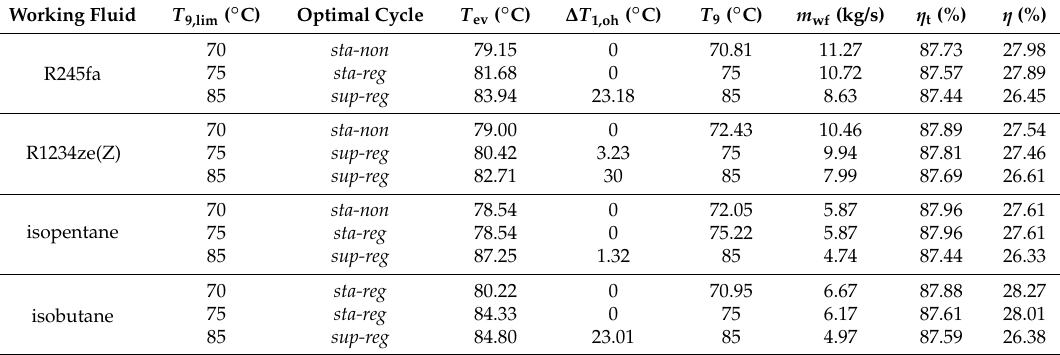
Table 7. Optimal cycle configuration and performances ( m hf = 10 kg/s, T 8 = 130 ◦ C). Working Fluid T 9,lim ( ◦